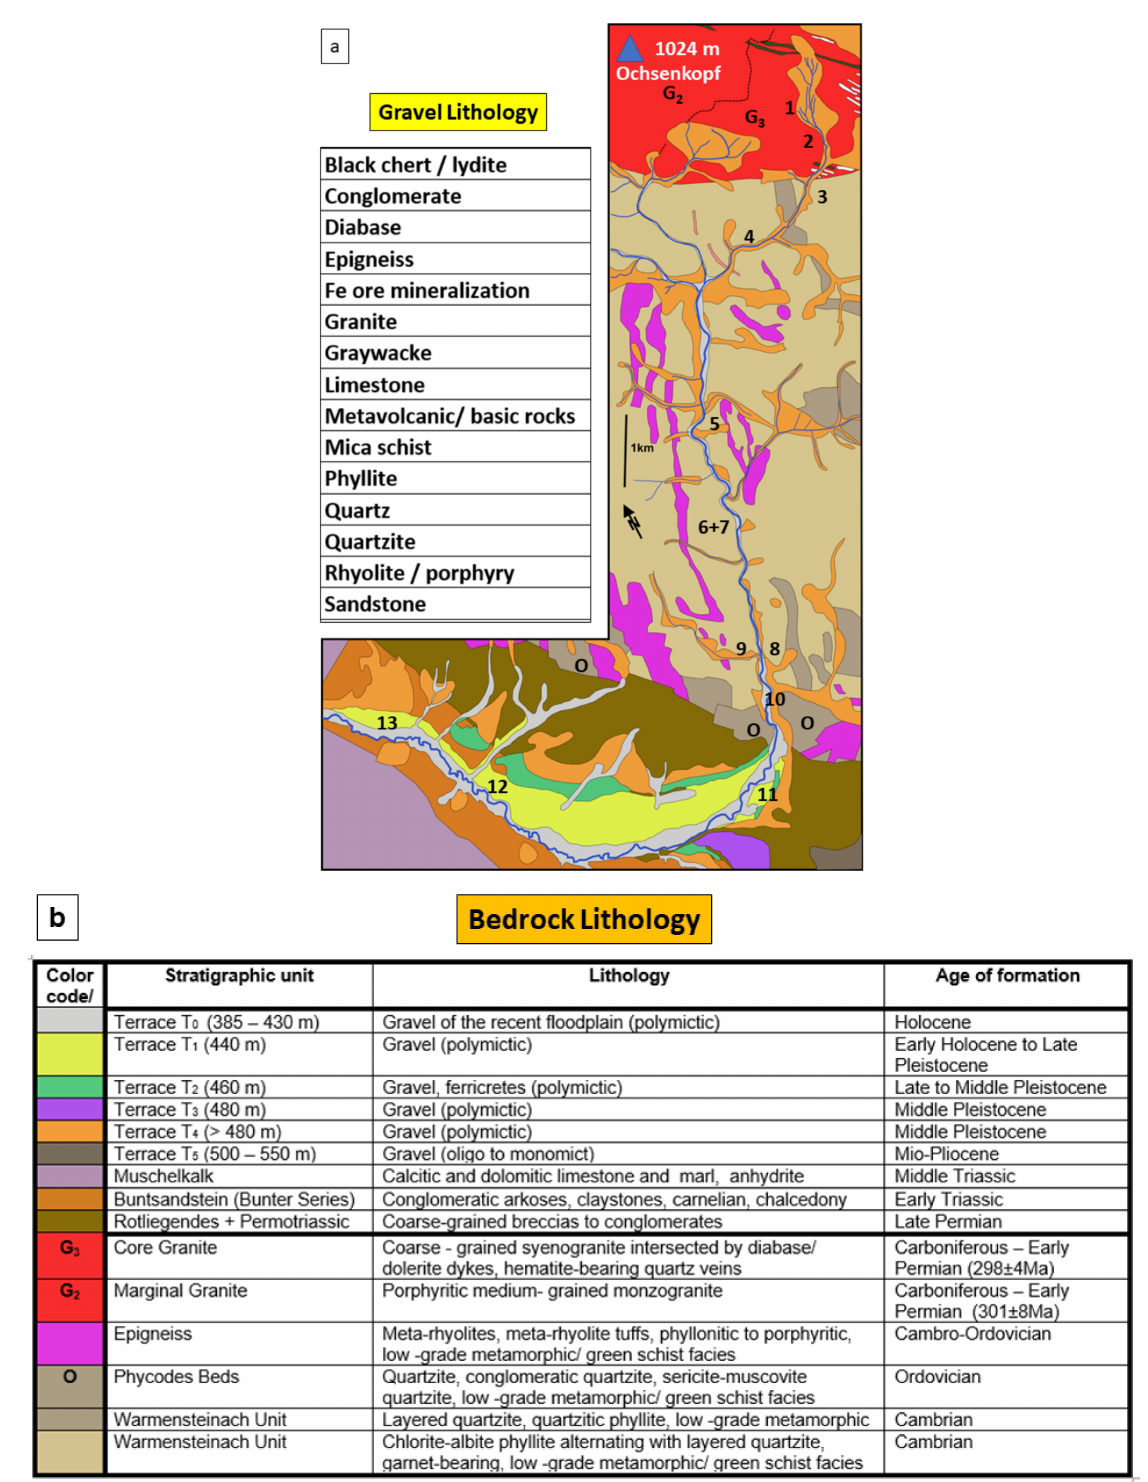
Figure 3. Geology of the bedrock and the gravel lithology of the study area sensu stricto along the Quaternary Steinach drainage system. ( a ) The geological setting (legend, see Figure 3b) and gravel lithology of the Steinach drainage system No. 1 to 13 refer to the sampling sites. ( b ) The legend for Figure 3a. G3 = granite No. 3, G2 = granite No. 2, O =